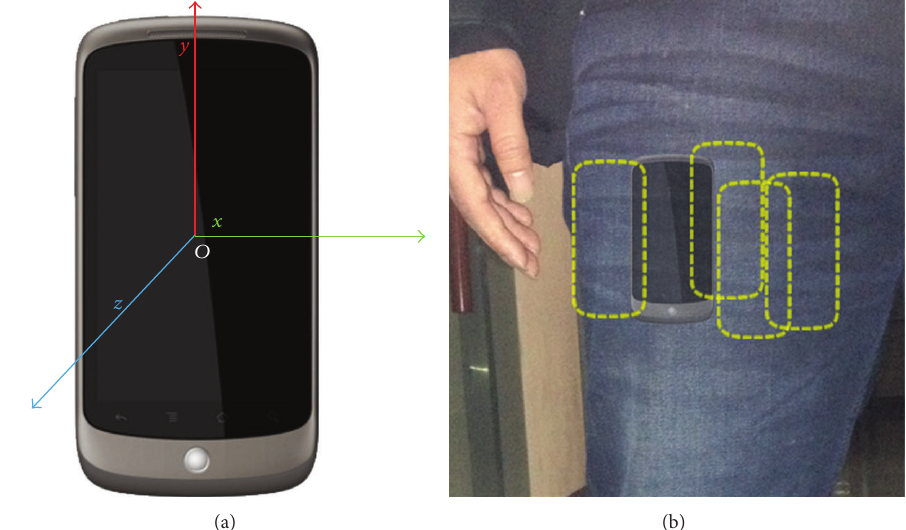
Figure 2: (a) Google Nexus One phone with a built-in 3-axial accelerometer and (b) the position of device put inside the front trouser pocket.